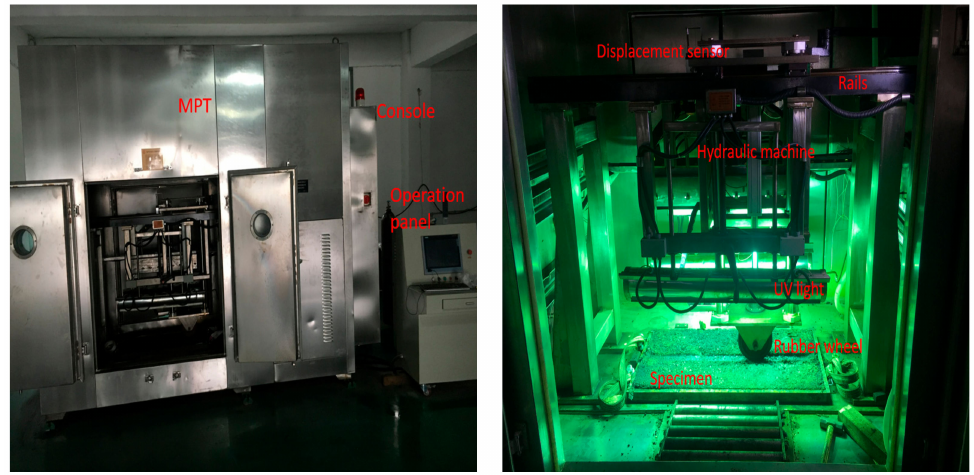
Figure 2. Multifunctional pavement material tester and its internal